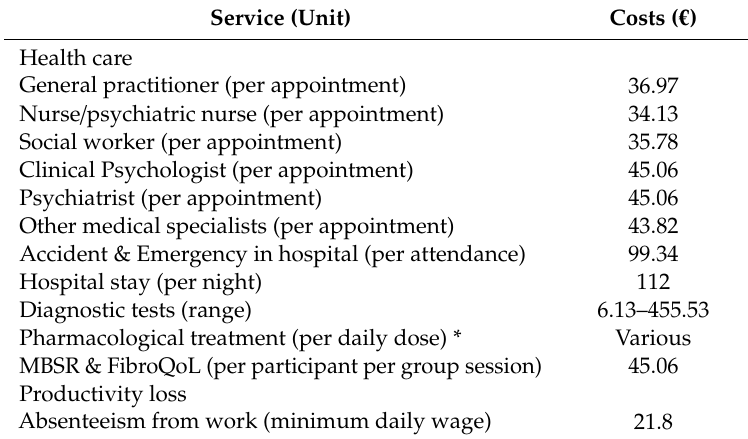
Table 1. Unit costs used in the calculations of direct and indirect costs (Financial Year 2016; values in € ). Service